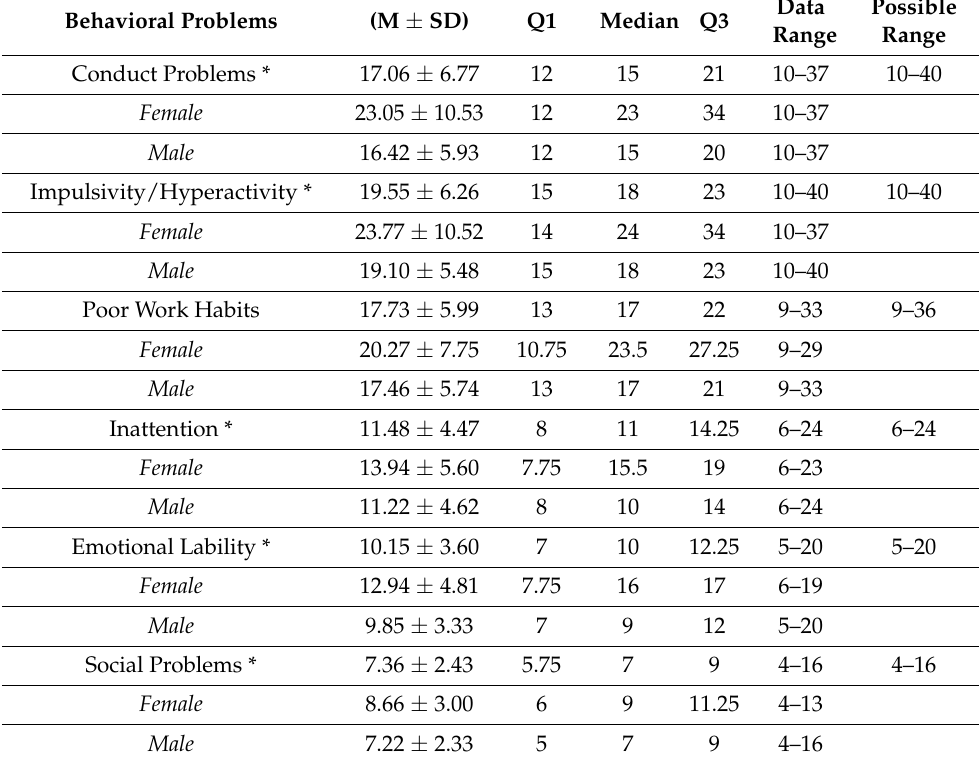
Data Possible Range Range